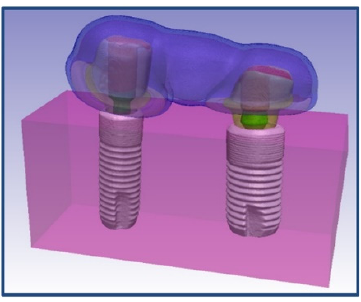
Figure 1. 3D model of an implant-supported FPD assembly.